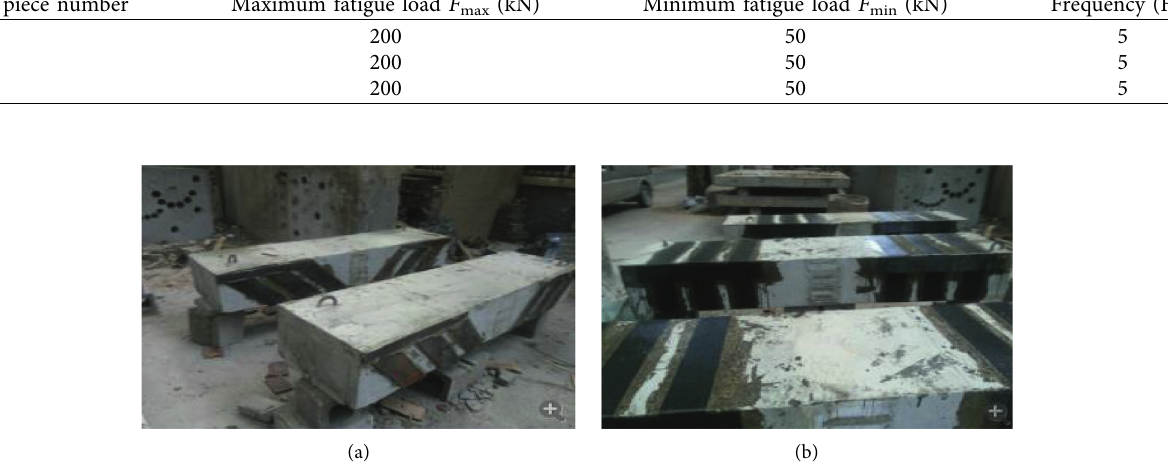
Figure 5: Reinforcement model: (a) steel plate reinforcement and (b) carbon fiber cloth reinforcement.